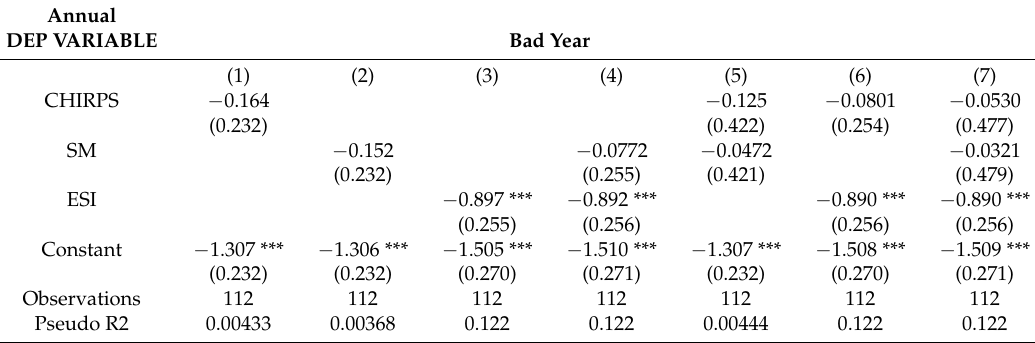
Table 2. Logit regression results for standardized anomalies of rainfall (Column 1), soil moisture (Column 2), ESI (Column 3), soil moisture and ESI (Column 4), rainfall and soil moisture (Column 5), rainfall and ESI (Column 6) and all variables combined (Column 7); “bad years” are the dependent variable; rows represent the regression coefficient for the three independent variables (rainfall, soil moisture, ESI), the regression constant, the number of observations, the pseudo R-squared, and the number of countries (8); asterisks mark statistically significant